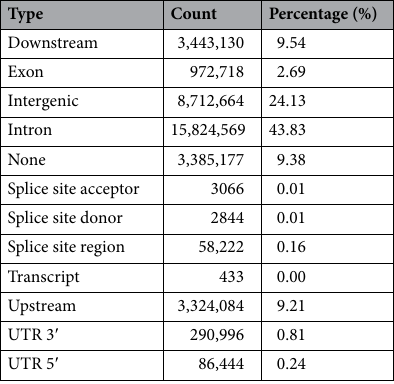
Table 3. Types of InDel polymorphisms identified in the genome sequences of seven hill pigeons and seven feral/domestic pigeons. UTR untranslated